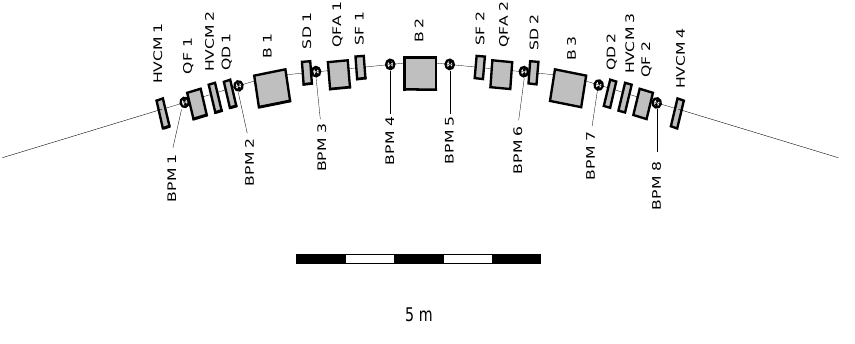
FIG. 1. Typical ALS storage ring sector.